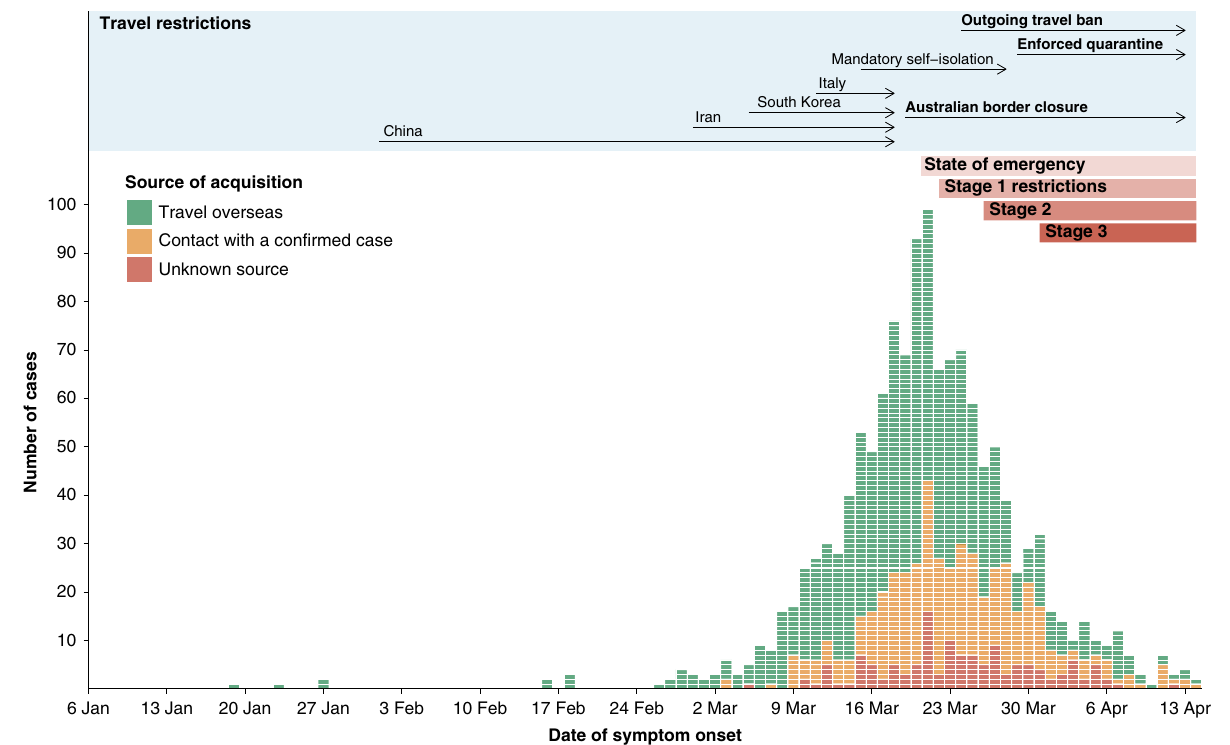
Fig. 1 Epidemic curve of the coronavirus disease (COVID-19) cases and implementation of public health interventions. Cases were categorized as (i) travel overseas if reporting travel in the 14 days prior to symptom onset or (ii) contact with a con fi rmed case if no overseas travel reported and case contact occurred within the same time period. Cases are plotted by reported date of symptom onset, or if unknown, date of initial specimen collection. The state of emergency declaration introduced a ban on large gatherings and mandatory social distancing of 4 m 2 per person. Stage 1 restrictions introduced a shutdown of nonessential services, followed shortly after by early commencement of school holidays. Stage 2 restrictions expanded shutdown of nonessential services, and Stage 3 introduced an enforceable stay-at-home order and limited non-household gatherings to two people.